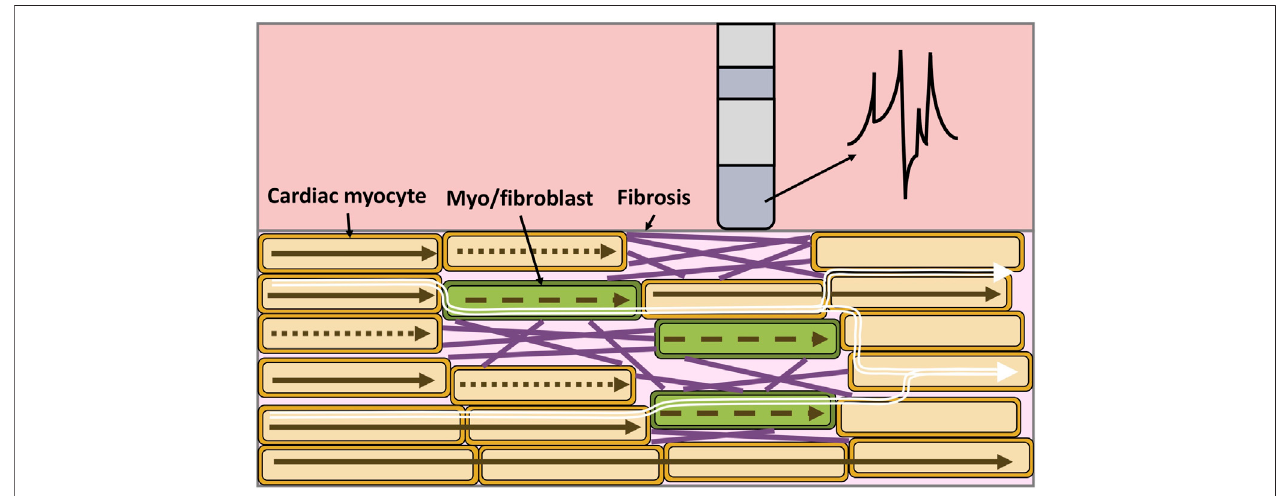
FIGURE 4 | Electrical propagation in fi brotic cardiac tissue, the composition is heterogeneous and includes cardiac myocytes (orange), myo fi broblasts/ fi broblasts (green) and collagen fi bers (purple). Depolarization of cardiomyocytes when an excitation propagates from left to right (brown arrows). Dotted arrows represent a conduction block, while dashed arrows represent slowed conduction. As a result of the zig-zag propagation of the wavefront (white arrows), the unipolar electrogram morphology is not symmetric, is prolonged and shows multiple de fl ections.